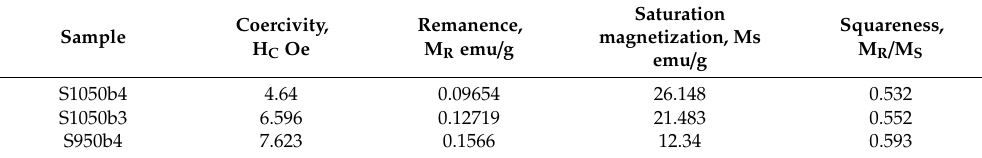
Figure 16. M–H curves of samples: ( a ) S1050b4; ( b ) S1050b3. Table 7. Magnetic parameters of samples S1050b4 and